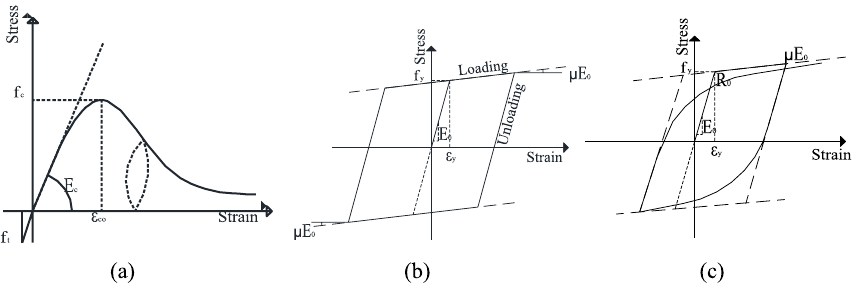
Fig. 4 Material model for ( a ) concrete, ( b ) non‑prestressing reinforcement, and ( c ) prestressing reinforcement (Abdelaziz et al.,